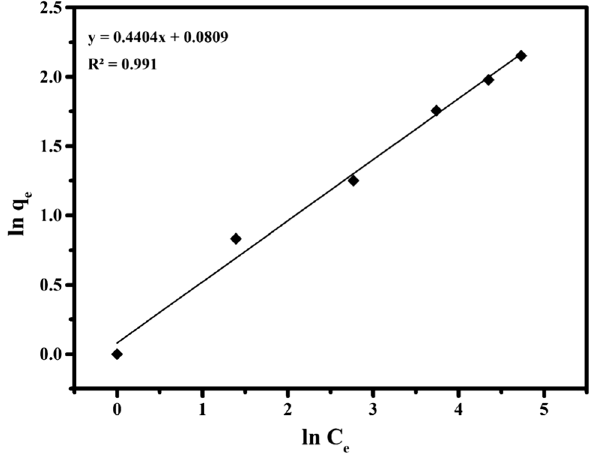
Fig. 8 Freundlich adsorption isotherm of MB dye adsorption on the PBF surface